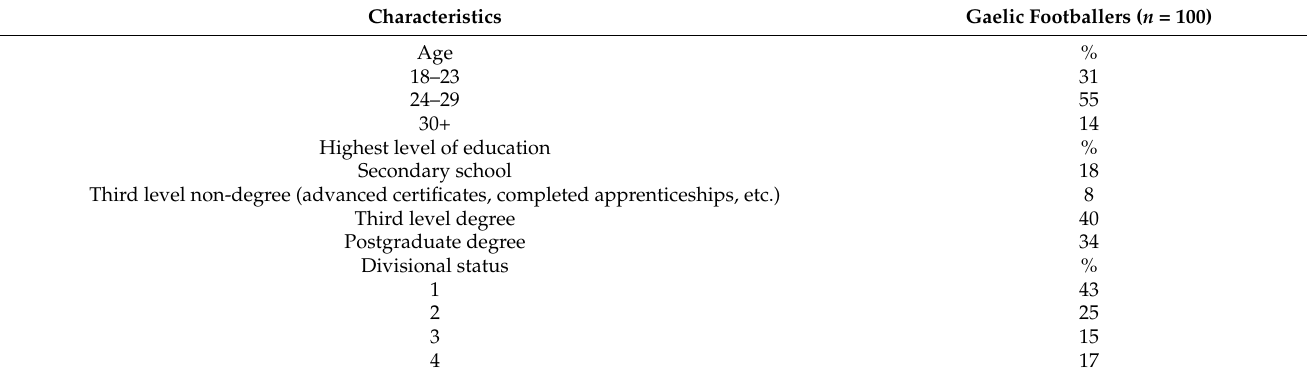
Table 1. Participant characteristics of Gaelic football players who completed the